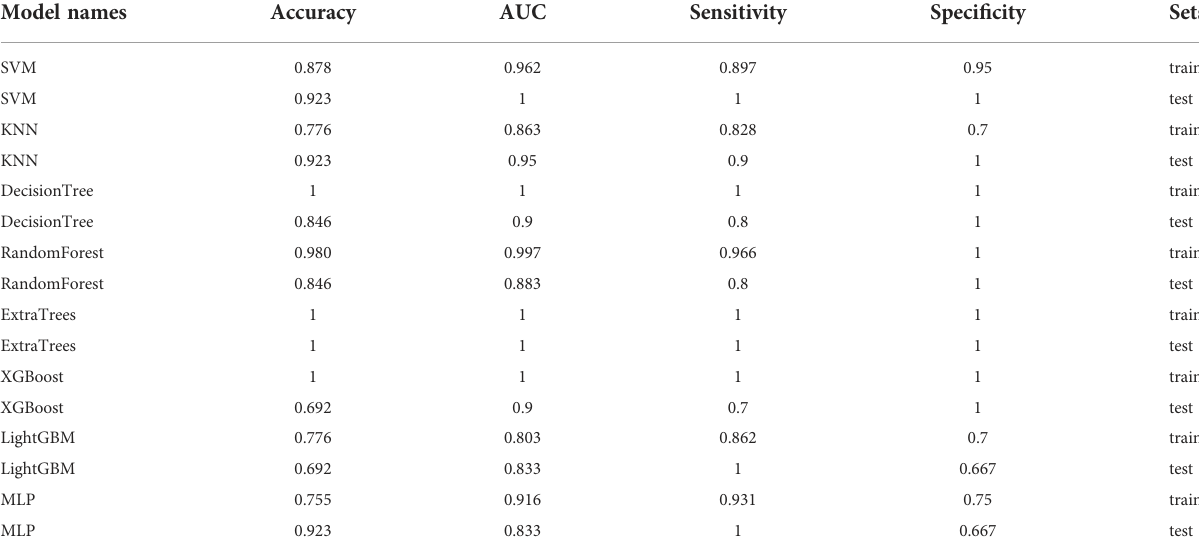
TABLE 7 Each evaluation index of the best performance of 100 random groupings in eight machine learning